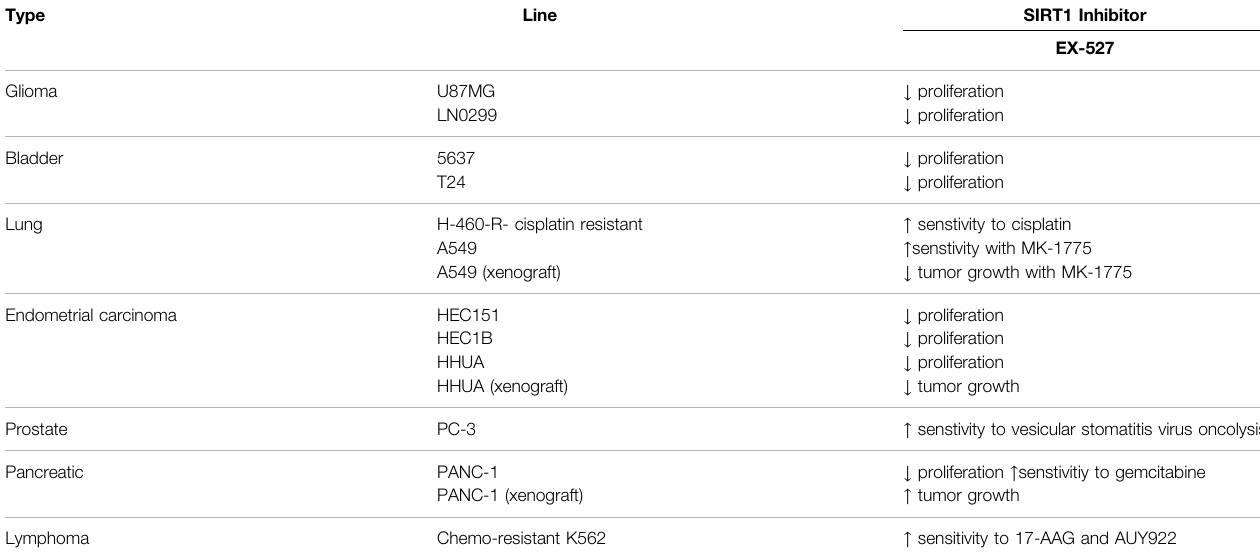
TABLE 2 | Cell lines affected by SIRT1